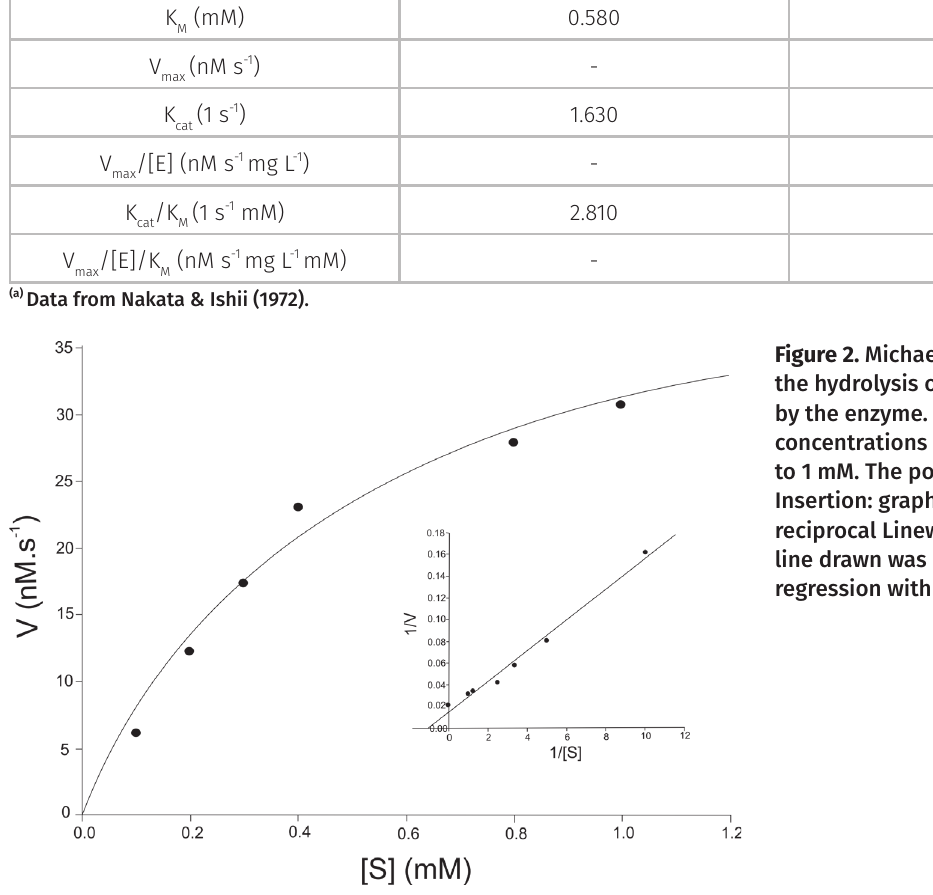
Table II. Kinetic parameters of the substrate hydrolysis L-BApNA by trypsin of the digestive serine proteases from Anticarsia gemmatalis (Lepidoptera: Noctuidae).